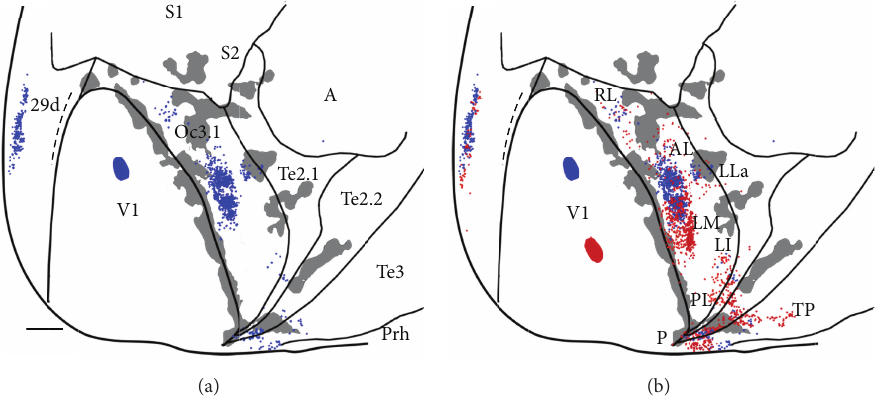
Figure 7: Data from case 86-12. ((a) and (b)) Labeling pattern resulting from an anteroposterior sequence of FB and RB injections. Callosal pattern (shown in Figure 3(a)) is indicated in grey. Medial is to the left and posterior is down. Scale bar = 2 mm.